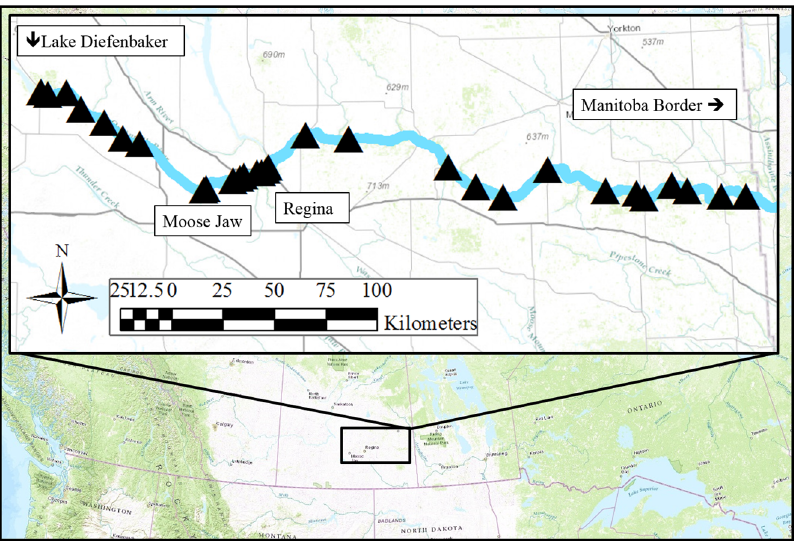
Figure 1. Location of the Qu’Appelle River, the river centerline, and the 35 macroinvertebrate sampling sites.